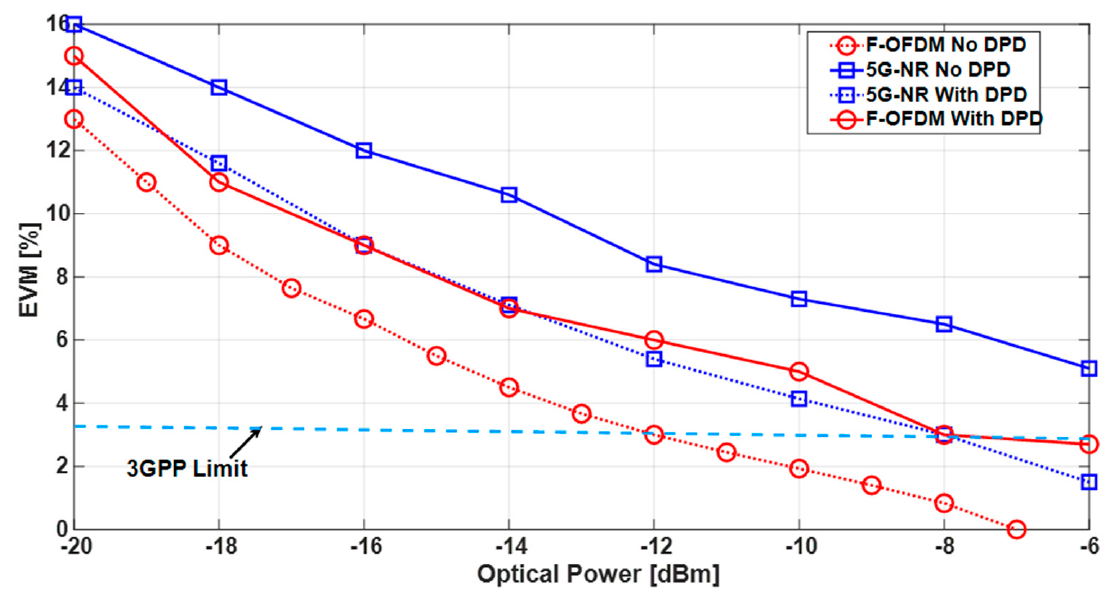
Figure 5. EVM performance comparison for 5G NR and F OFDM waveforms with and without DPD for the received optical power.